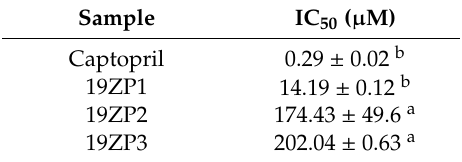
Figure 5. Cellular uptake of peptides by HEK-293 ( a ) and HuH7 ( b ) cells as measured by flow cytometry. The cells were treated with 10 µM peptide for 1 h. The peptide sC18 was used as a positive control. Results are expressed as mean values ± standard deviation; n = 3. Superscript letters represent statistical differences among samples. Statistical differences were determined by Tukey’s test ( p < 0.05). Table 2. Half maximal inhibitory concentrations (IC 50 ) for ACE